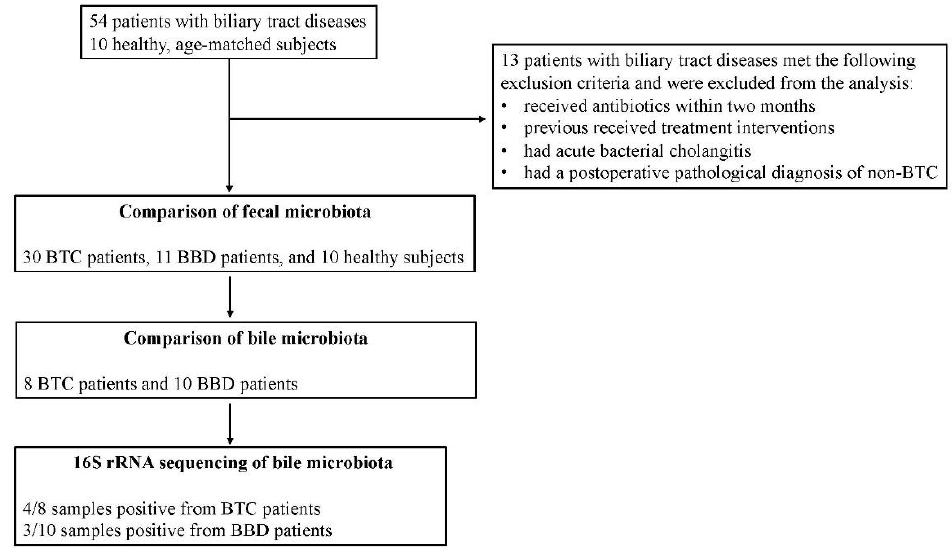
Figure 1. Overview of patient selection and analysis of each sample in this study.